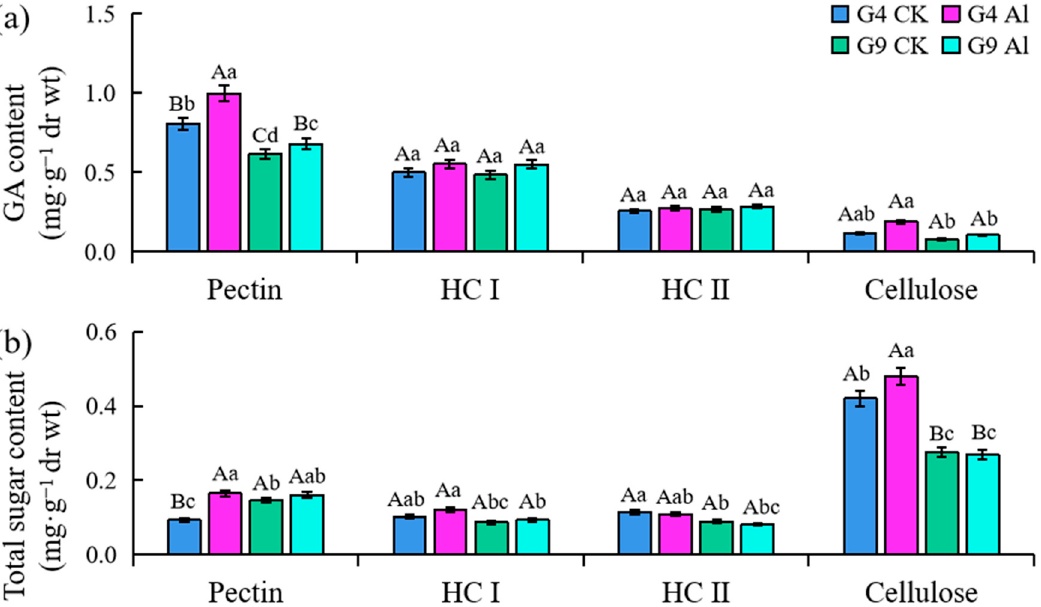
Figure 4. ( a ) Galacturonic acid (GA) and ( b ) total sugar content of cell walls extracted from root tips of Eucalyptus clones G4 and G9. Two-month-old seedlings were exposed to 0 or 4.4 mM Al solution for 24 h. Root apices were cut, and cell wall polysaccharides were fractionated into pectin, hemicellulose I (HC I), and hemicellulose II (HC II) for GA content measurement. Note: different lowercase and uppercase letters indicate significant differences at the levels of 0.05 and 0.01, respectively.